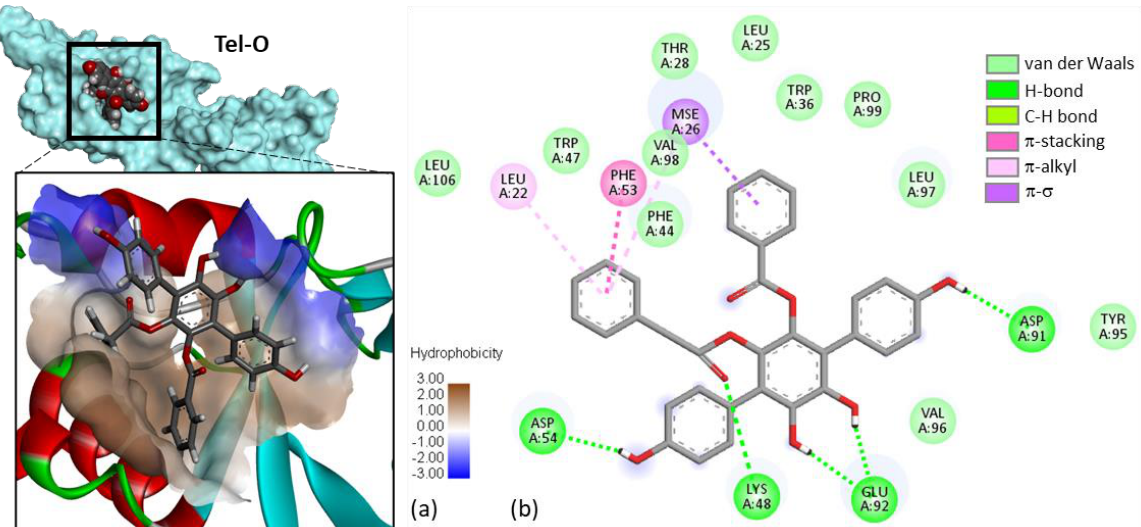
Figure 5. Docking model of telephantin O (Tel-O) bound to USP4. ( a ) Surface model of Tel-O bound to the V98 site, with a close-up view of the compound in the binding site, and the hydrophobic/hydrophilic zones colored in brown and blue, respectively. ( b ) Binding map contact, with the indicated color code.